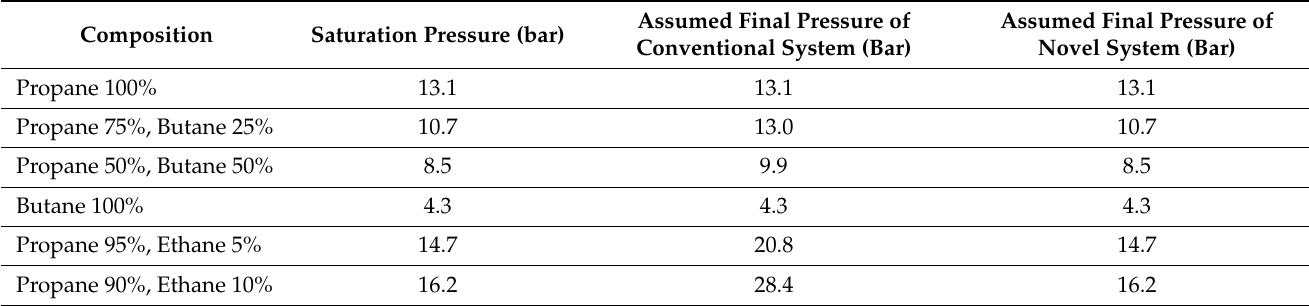
Table 5. Saturation pressures and assumed final pressures of the conventional and novel re- liquefaction and fuel supply systems with LPG compositions (the temperature is 38 ◦